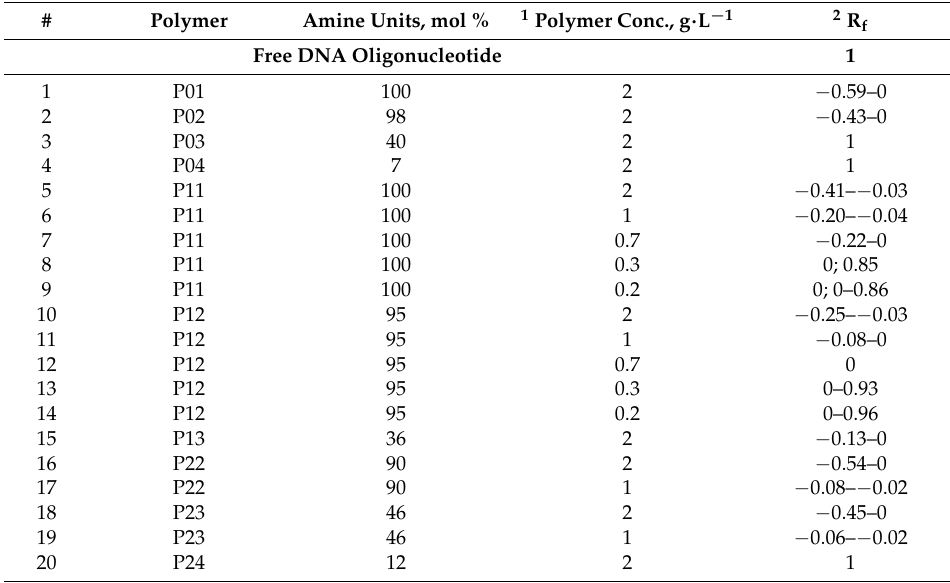
1 DNA oligonucleotide was applied as 10 µ M solution. Polymer:oligonucleotide ratio (volume to volume) was 2:1. 2 Negative R f values correspond to substance movement towards the negative electrode. Interval of R f values corresponds to spreading electrophoretic